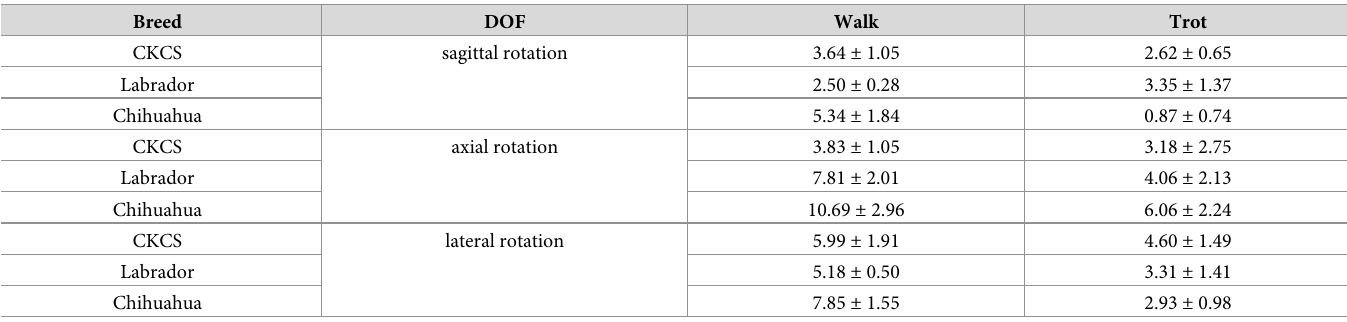
Table 2. Range of motion of the rotations of C2/C1 IVJ (atlantoaxial joint). Breed